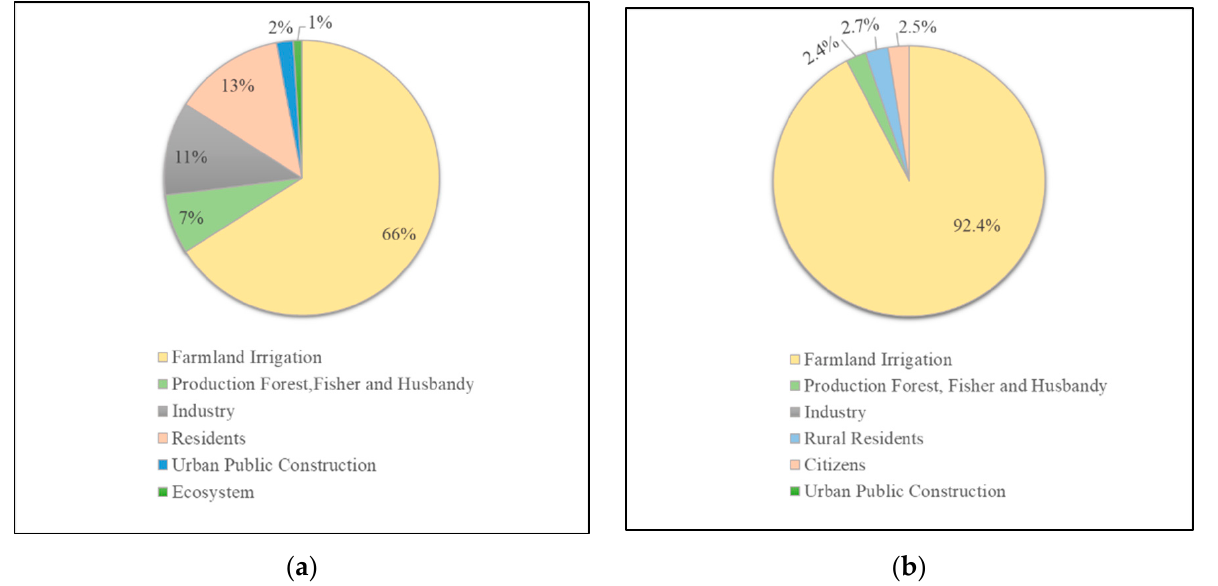
Figure 4. Water consumption structure ( a ) and proportion of water-saving potential ( b ) in Zhangjiakou.